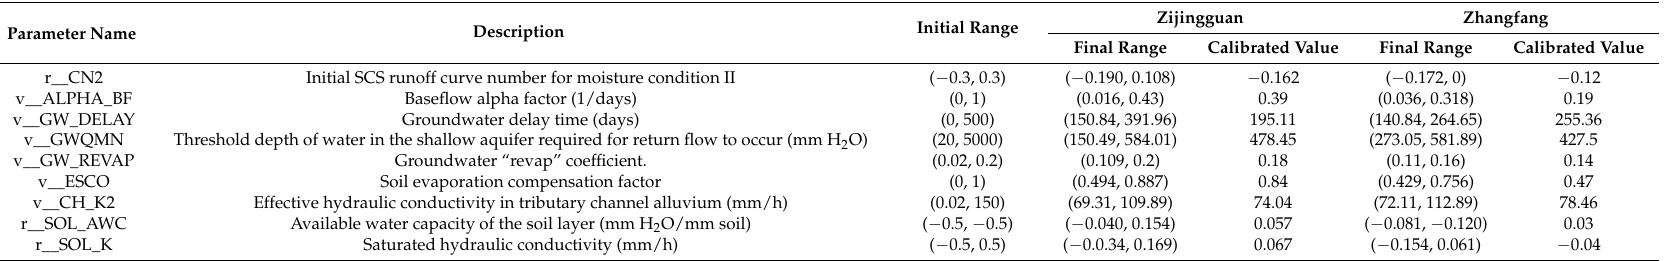
Table 2. The calibrated values of the model